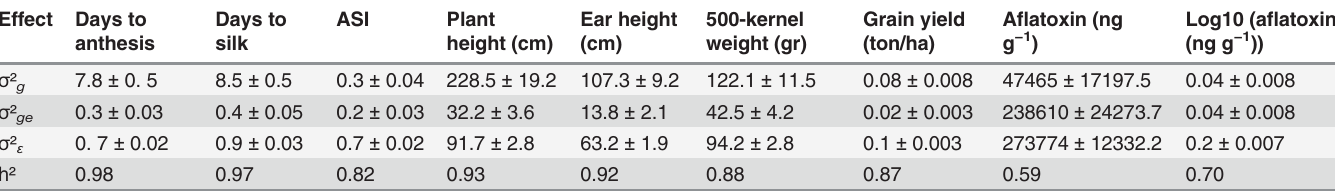
Table 2. Variance components and heritability estimates for all traits across all trials.